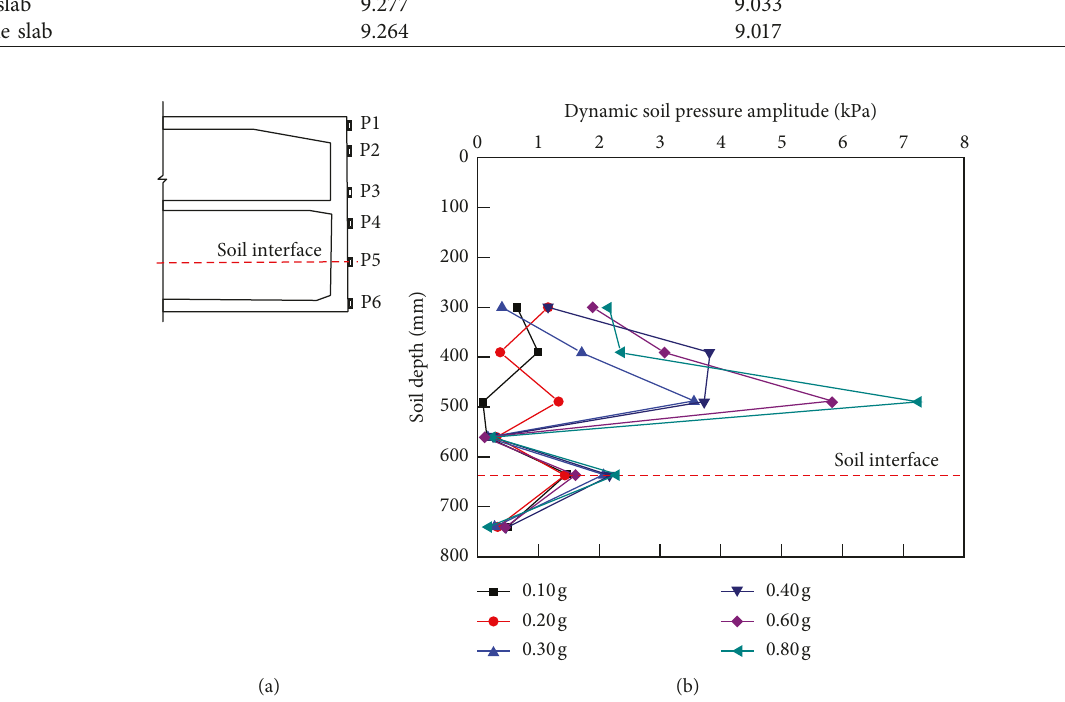
Figure 16: Dynamic soil pressure amplitude under the Kobe ground